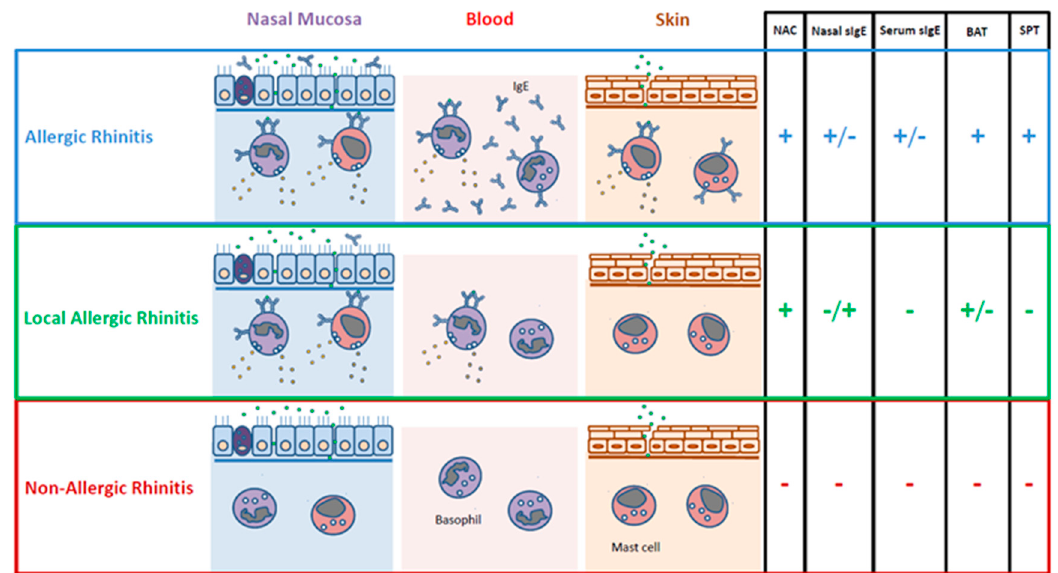
Figure 1. In vivo and in vitro biomarkers for rhinitis phenotypes. NAC: nasal allergen challenge; sIgE: allergen-specific IgE; BAT: basophil activation test; SPT: skin prick test.